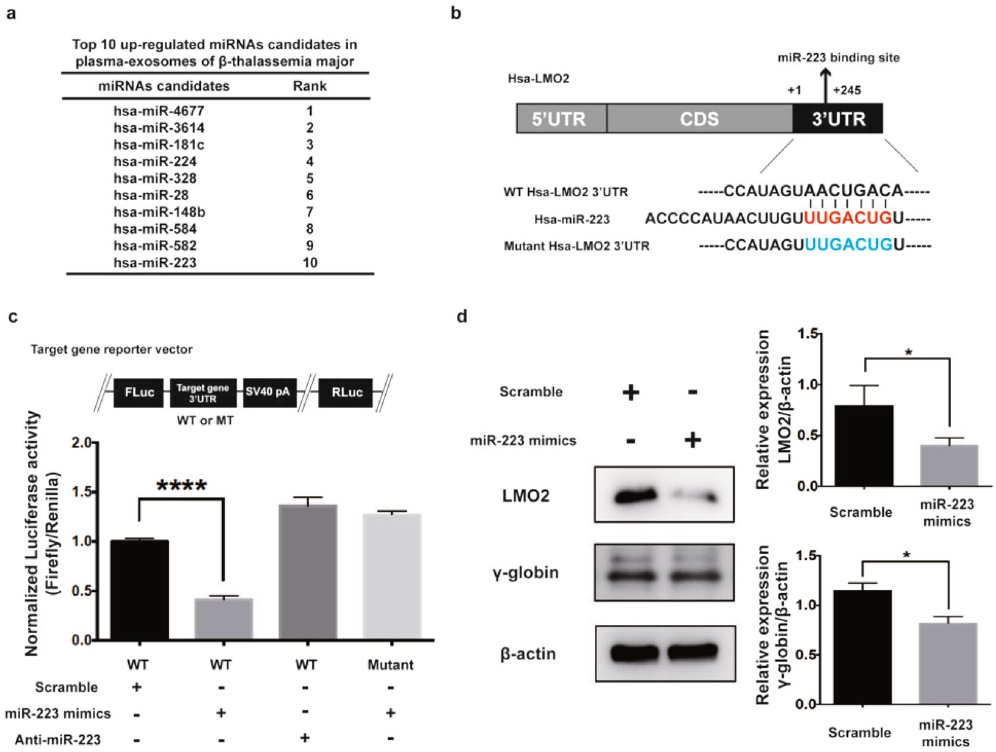
Figure 3. miR-223-3p down regulates LMO2 and γ -globin expression. ( a ) Top10 up-regulated miRNA candidates in the plasma exosomes of β -TM as determined by NGS analysis. ( b ) Predicted miR-223-3p binding site in the 3 ′ UTR of LMO2 with sequence complementarity. ( c ) Schema of a reporter vector (pmirGLO) carrying either WT or mutant 3 ′ UTR of LMO2. Luciferase assays using reporter vector (pmirGLO) carrying either WT or mutant 3 ′ UTR of LMO2 in K562 cells transfected with scramble control microRNA mimics (controls, 100 nM), miR-223-3p mimics (100 nM) or anti-miR-223-3p (antagomir, 100 nM) for 24 hr. Experiments were performed in triplicates. The values represented are mean ± SD, one-way ANOVA, **** P < 0.0001, Prism6 (GraphPad Software Inc.). ( d ) Immunoblot of LMO2 and γ -globin expression